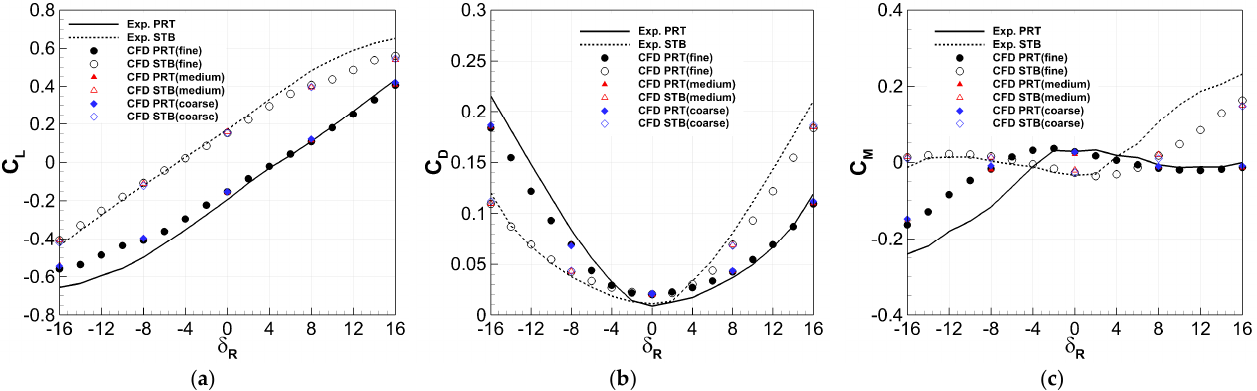
Figure 6. Measured and numerically predicted rudder forces and moment for the twin flat rudders: ( a ) lift force; ( b ) drag force; ( c ) moment.